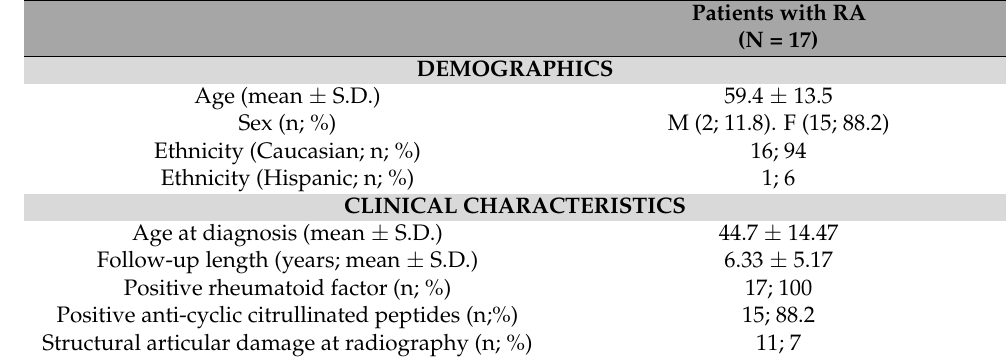
Table 1. Baseline demographic and clinical characteristics of the patients enrolled in the study who completed follow-up. RA—rheumatoid Arthritis.